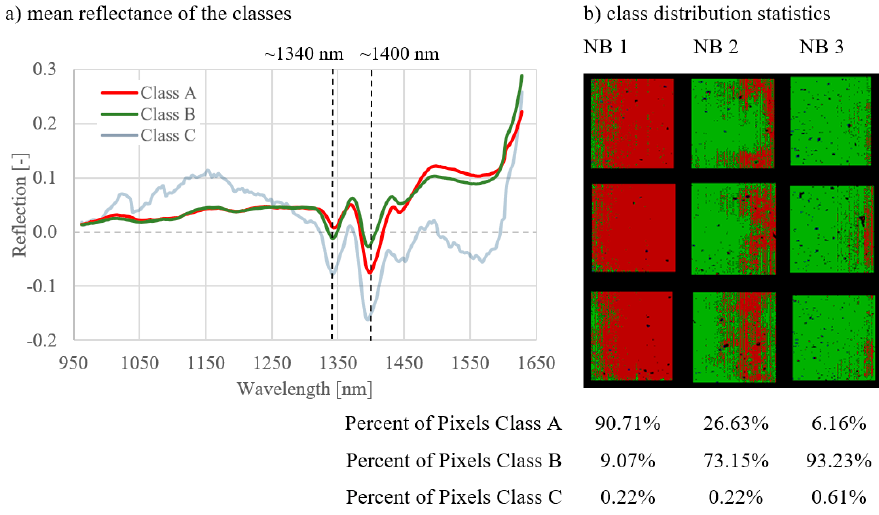
Figure 5. Results for combination 1; comparison of three curing types on day 1.